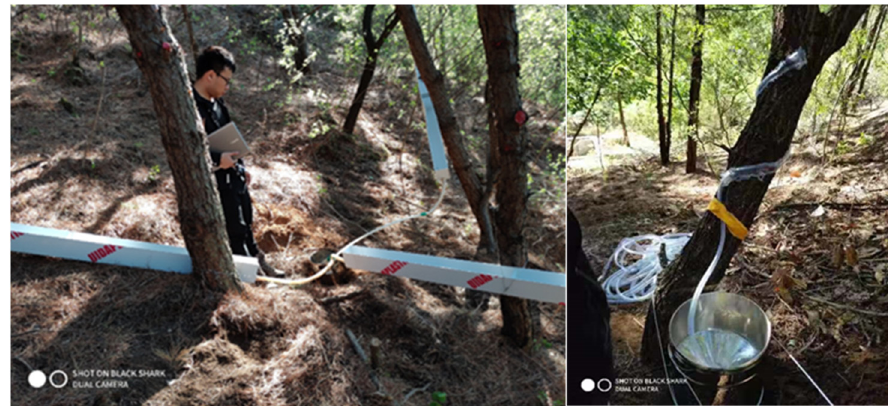
Figure 2. The photo of measurements for canopy interception and stemflow.